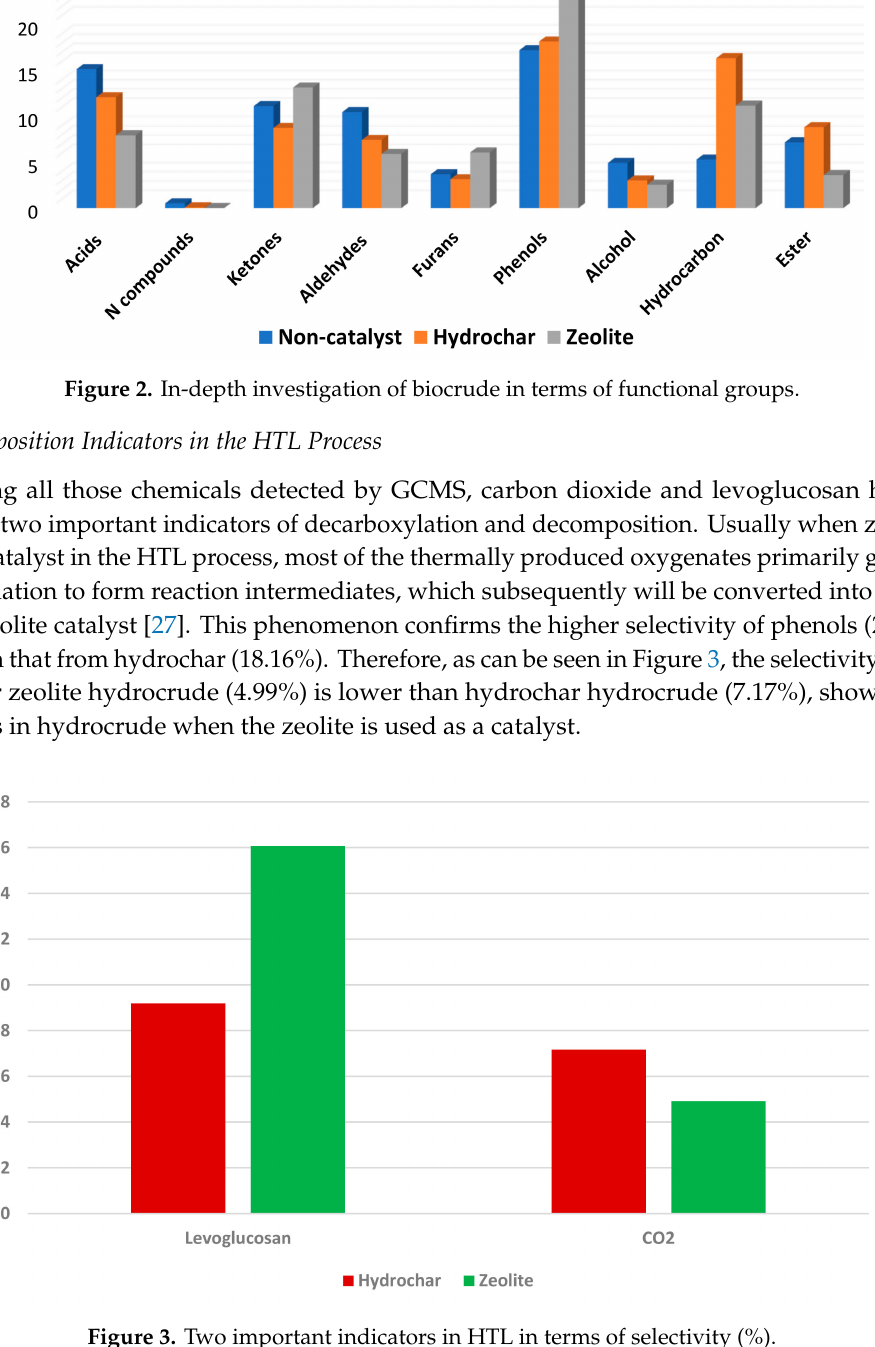
Figure 3. Two important indicators in HTL in terms of selectivity